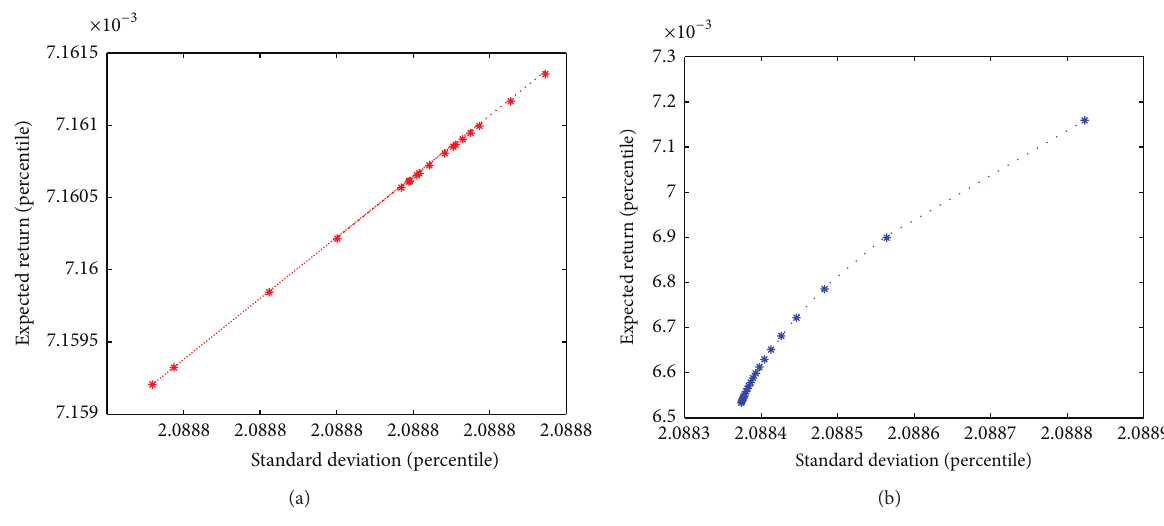
Figure 2: Efficient frontier obtained by Models 1 and 3 for Example